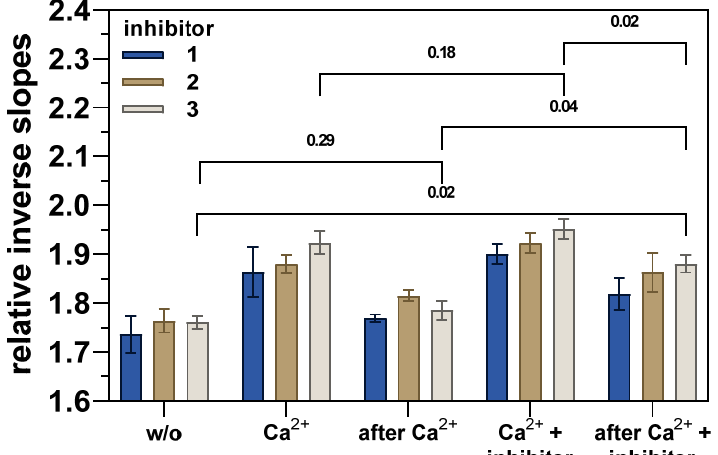
Figure 6. Changes of the hTGase 2-dsDNA lever upward motion (non-directed labeling) in response to Ca 2+ (1 mM), the inhibitor (10 µ M), and the removal of both effectors (dynamic mode, 0.1% DMSO). The notations for the resulting solvent composition and/or state of the hTGase 2-dsDNA lever are based on the treatment sequence explained in the text. The DNA lever motion was analyzed based on the inverse slope at the inflection point of the time-dependent normalized fluorescence intensity curve. The obtained values were divided by the inverse slope of the bare dsDNA to calculate respective relative values. A higher relative inverse slope indicates higher friction of the hTGase 2-dsDNA lever. Shown are mean values (four electrodes of one experiment) ± standard deviation. For statistical comparison of the effect of the three inhibitors and the treatment on the relative inverse slopes, the values were subjected to a two-way repeated measure ANOVA with Tukey’s multiple comparison test (matched values for the relative inverse slopes obtained for the same electrode). p values are given above the brackets and values <0.05 were considered statistically significant. The results of the multiple comparison test for inhibitor 3 are shown. For statistical comparisons of inhibitors 1 and 2 , see Figure S4 in Supplementary Materials.